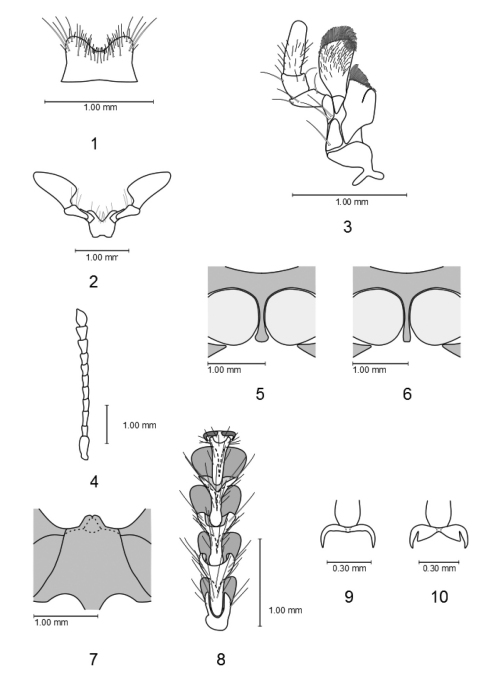
1–4 Labrum, labium, maxille and antenna of Orthrius sepulcralis
5 Pro-intercoxal process of Xenorthrius robustus
6 Pro-intercoxal process of Orthrius sepulcralis
7 Anterior mesosternal process of Xenorthrius robustus
8–9 Tarsus and claws of Orthrius sepulcralis
10 Claws of Xenorthrius robustus.